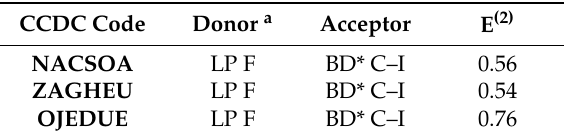
Table 3. Donor and acceptor NBOs with indication of the second-order interaction energy E (2) (kcal/mol) for NACSOA, ZAGHEU, and